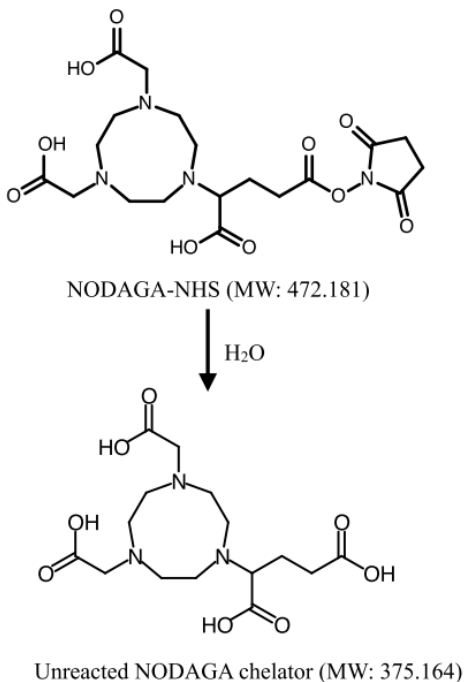
Figure 19. Hydrolysis of NODAGA ‐ NHS into unreacted NODAGA chelator.